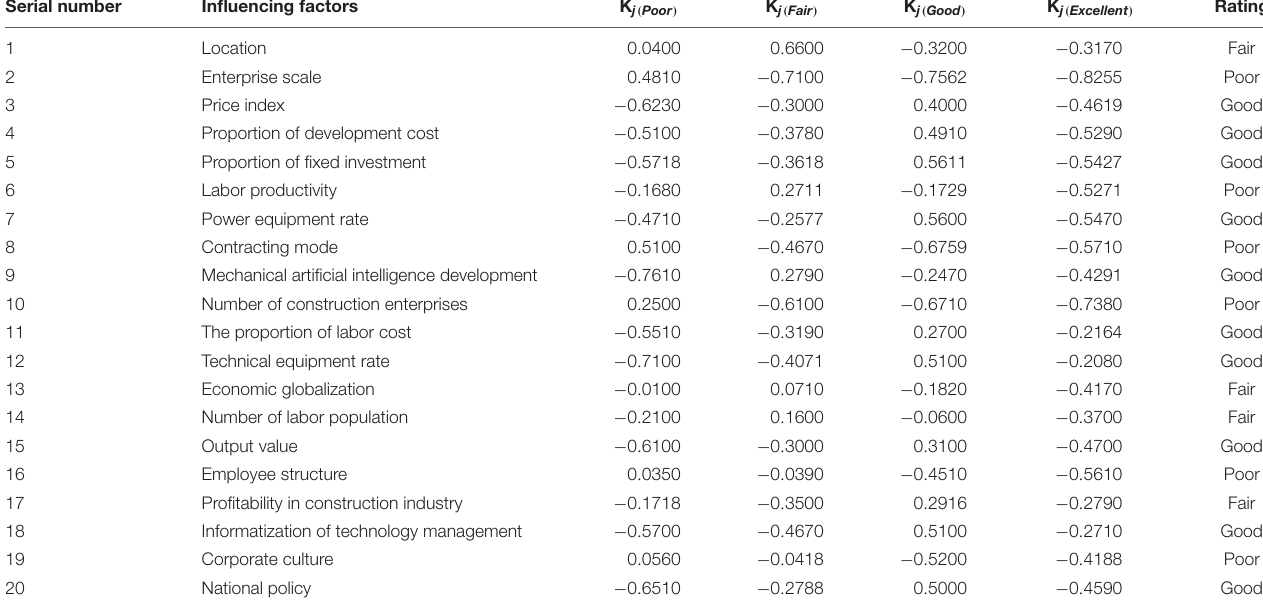
TABLE 8 | Correlation degree of each factor.